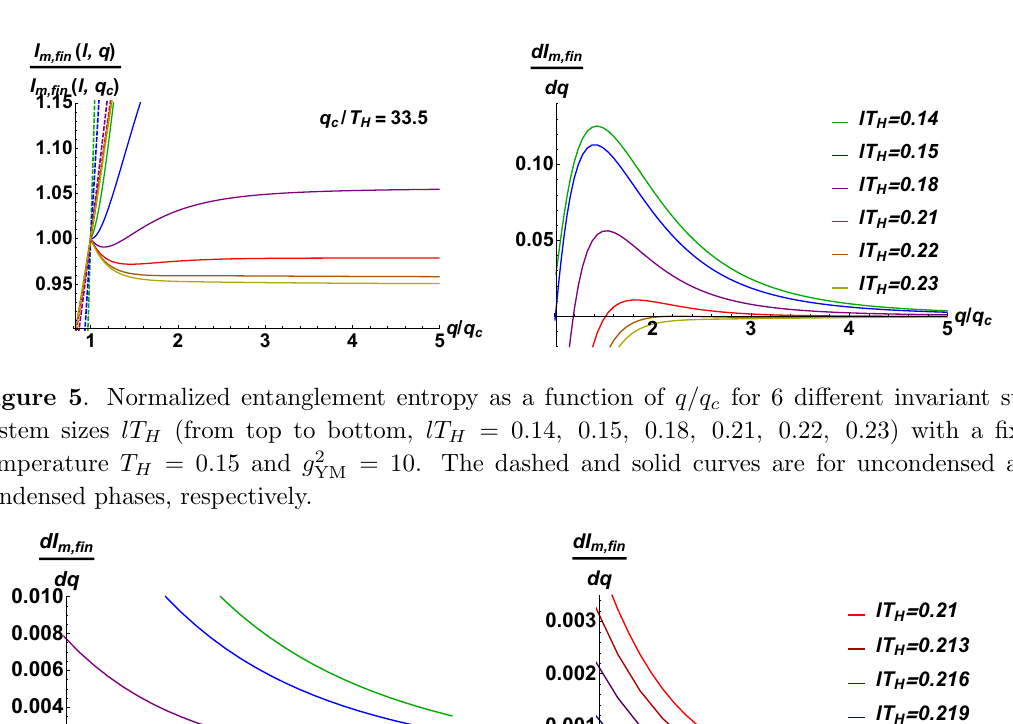
= 6. We plot the YM